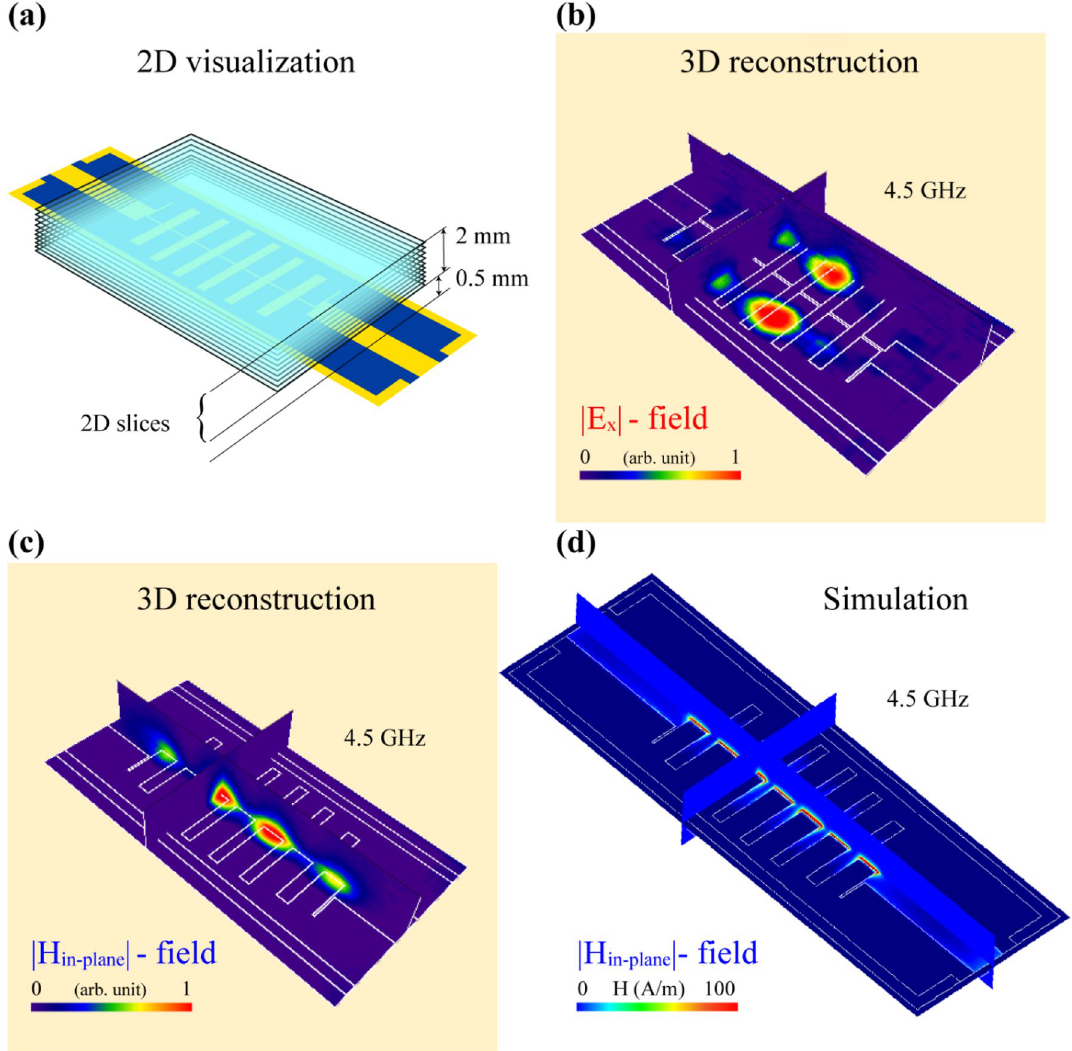
Figure 5. ( a ) Illustration of the LPF under test with the OI placed at different locations from metasurface with the various measurement steps. 3D reconstruction of the LPF at 4.5 GHz for ( b ) x -component of electric field distribution (| E x |) and ( c ) in-plane magnetic field distribution (| H in-plane |). ( d ) Simulation result for in-plane magnetic field